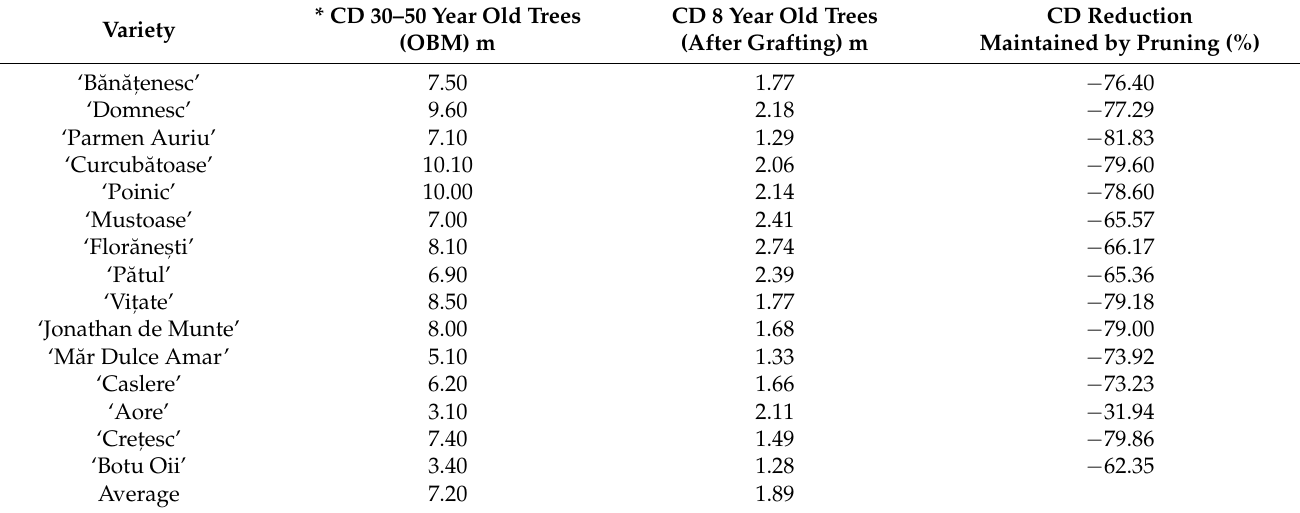
Table 3. Differences between crown diameter before and after